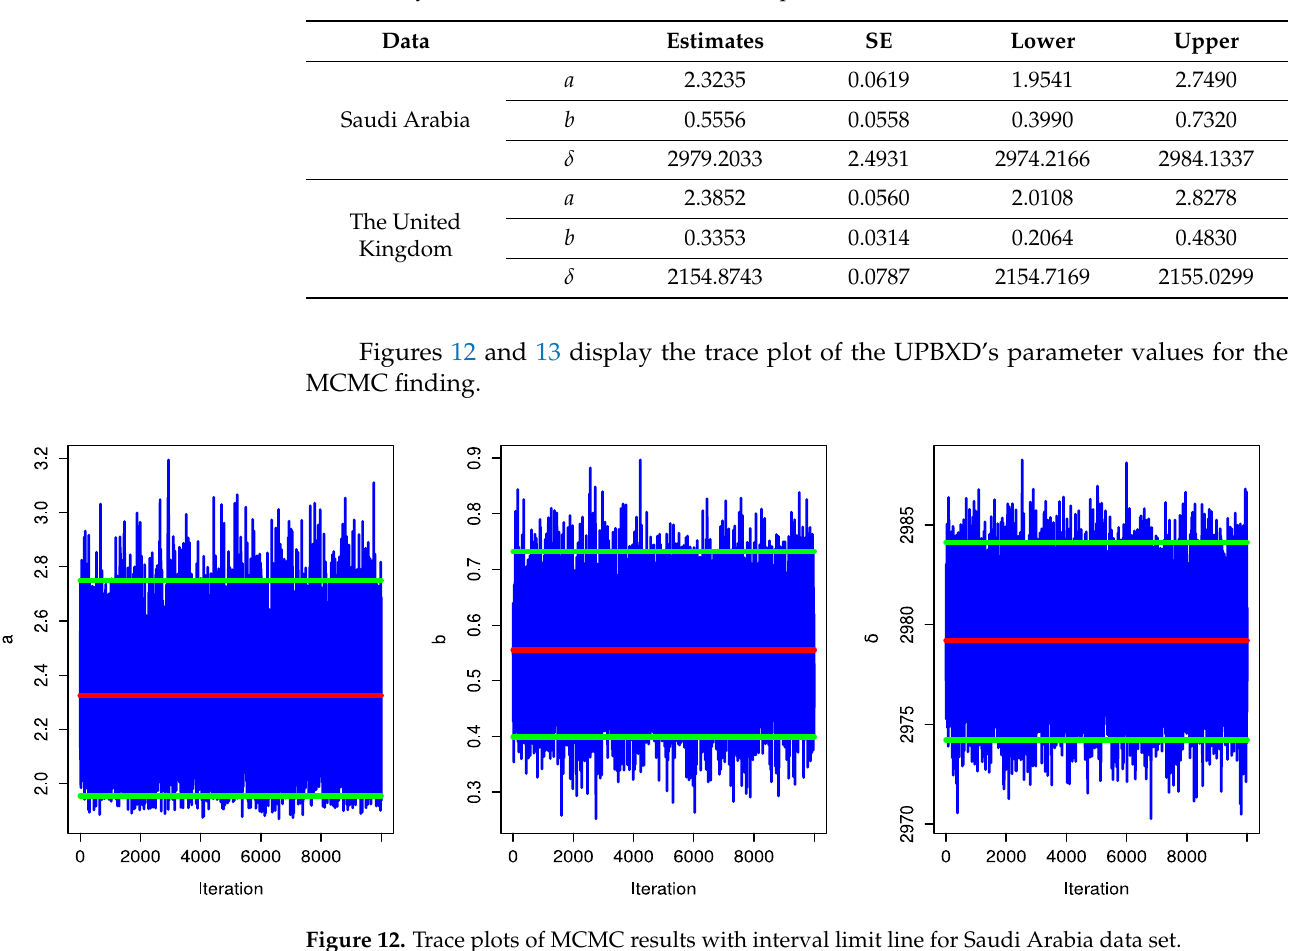
Figure 14. The ACF plot of MCMC results for Saudi Arabia data set.